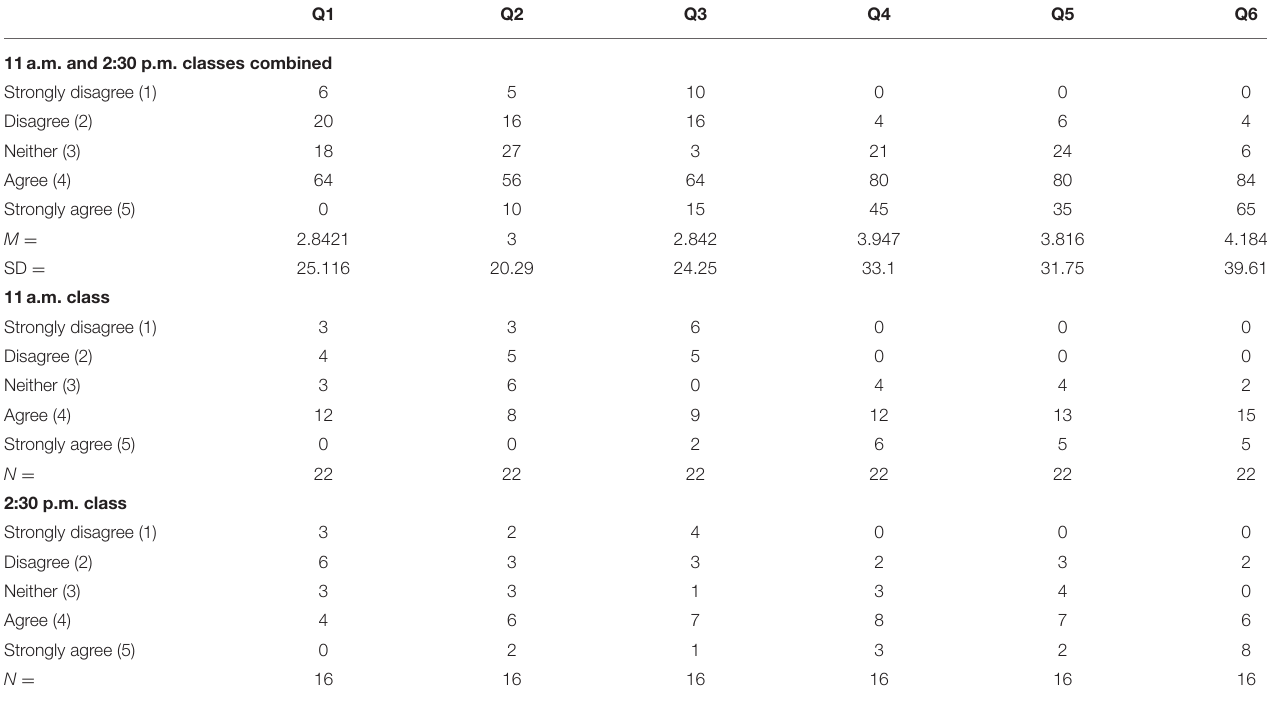
TABLE 1 | Wellness check and online feedback survey (closed-ended